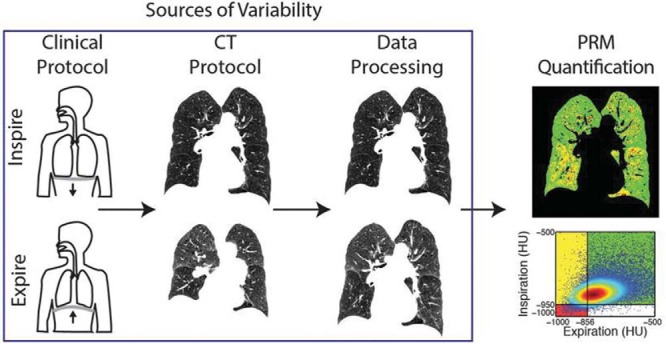
Schematic of modes of variability at various stages in the PRM workflow. Clinical protocol consists of patients being trained to hold their breath at full inspiration and full or relaxed expiration. CT protocol guides acquisition at both points using site-specific CT systems, acquisition parameters, and reconstruction kernels. Data processing consists of lungs from the serial CT scans being segmented from the thoracic cavity and then spatially aligned to a single geometric frame using site-specific algorithms. PRM quantification is performed by classifying voxels with paired HU values as normal parenchyma (green voxels), functional small airways disease (yellow voxels), or emphysema (red voxels).